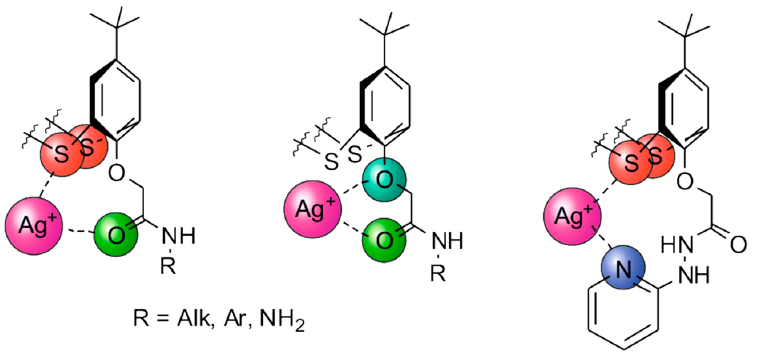
Figure 6. Possible coordination of silver ions with amide derivatives of thiacalix[4]arene.